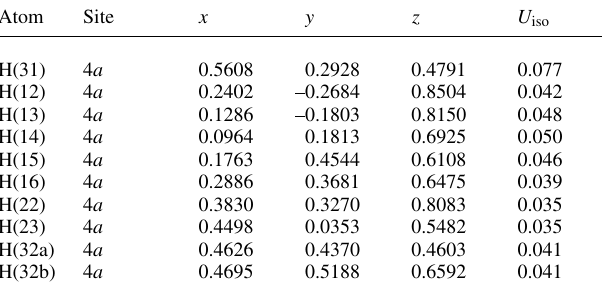
Table 2. Atomic coordinates and displacement parameters (in Å 2 ) .